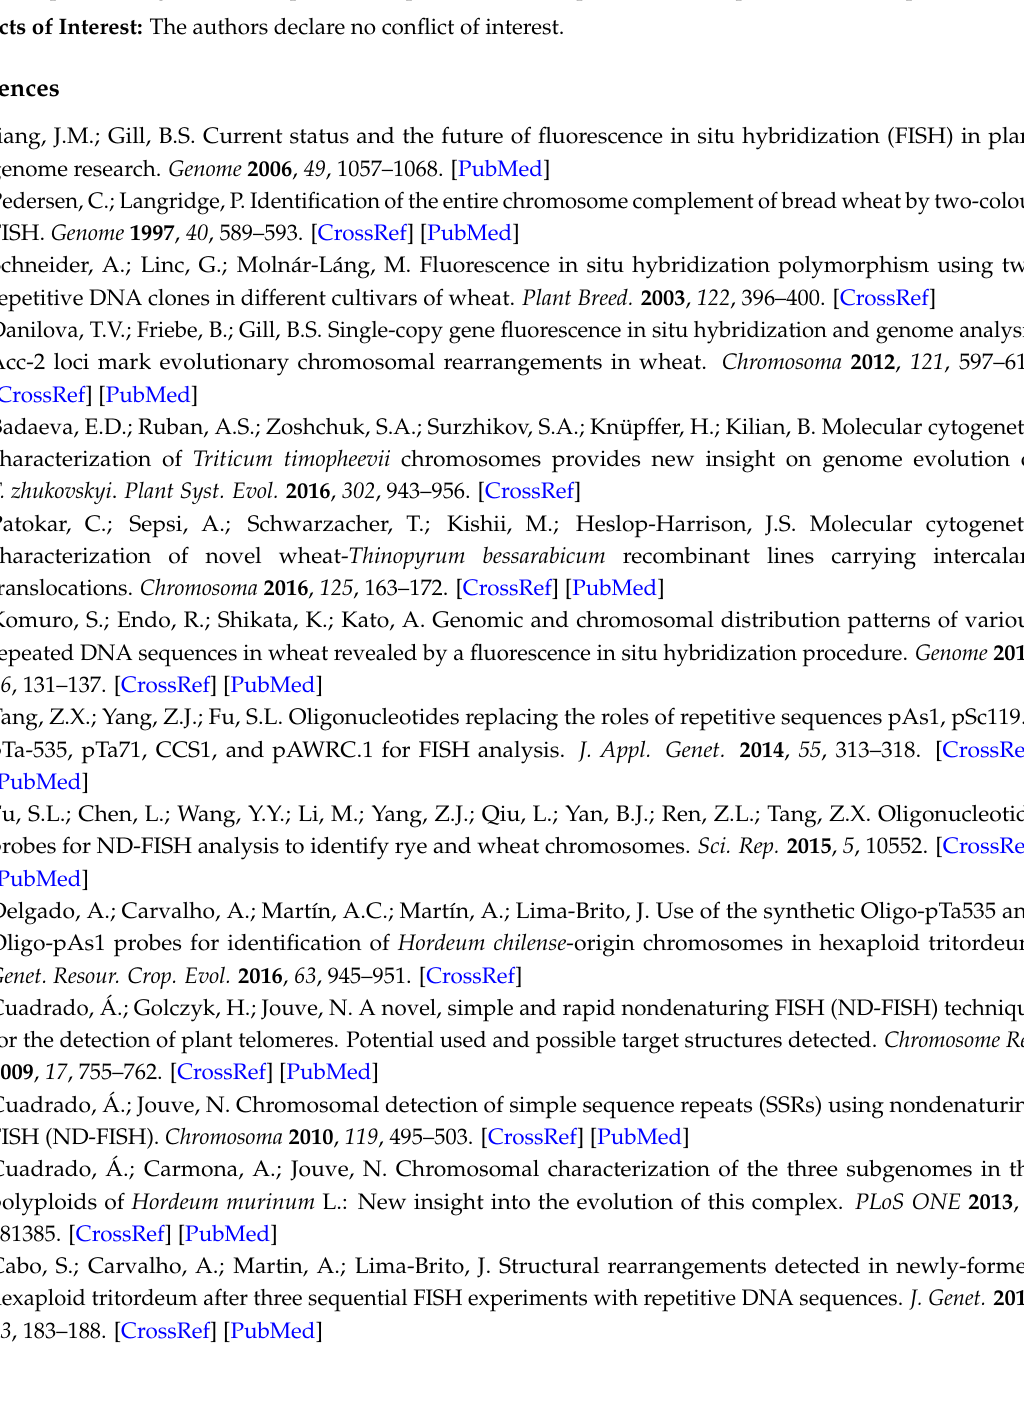
(yellow) and Oligo-pSc119.2-1 (red) was used as probes for ND-FISH analysis. Figure S7: Oligo-713 (green) combined with Oligo-pTa535-1 (yellow) and Oligo-pSc119.2-1 (red) was used as probes for ND-FISH analysis. Figure S8: Sequence alignment between cloned repetitive sequences and their corresponding original repetitive sequences. Figure S9: Oligo-pTa71-1 (green) and pTa71 (red) were used as probes for denaturing FISH analysis. Figure S10: Oligo-HvT01 (red) and pMD-HvT01 (green) were used as probes for denaturing FISH analysis. Figure S11: Oligo-s120.3 (green), Oligo-k566 (green), pMD-120 (red) and pMD-566 (red) were used as probes for denaturing FISH